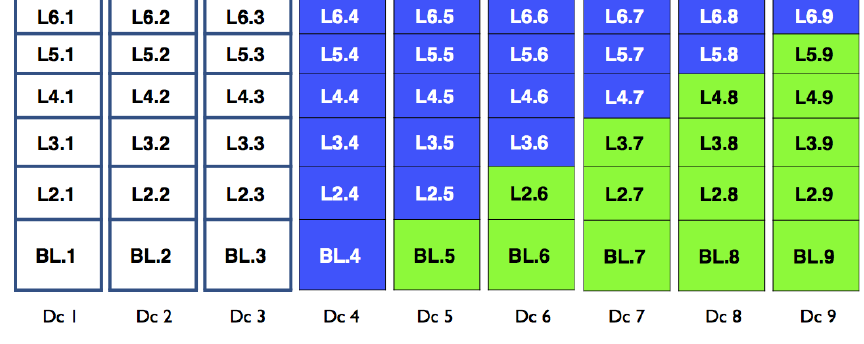
Figure 5. ALD with six-layer and an STF of